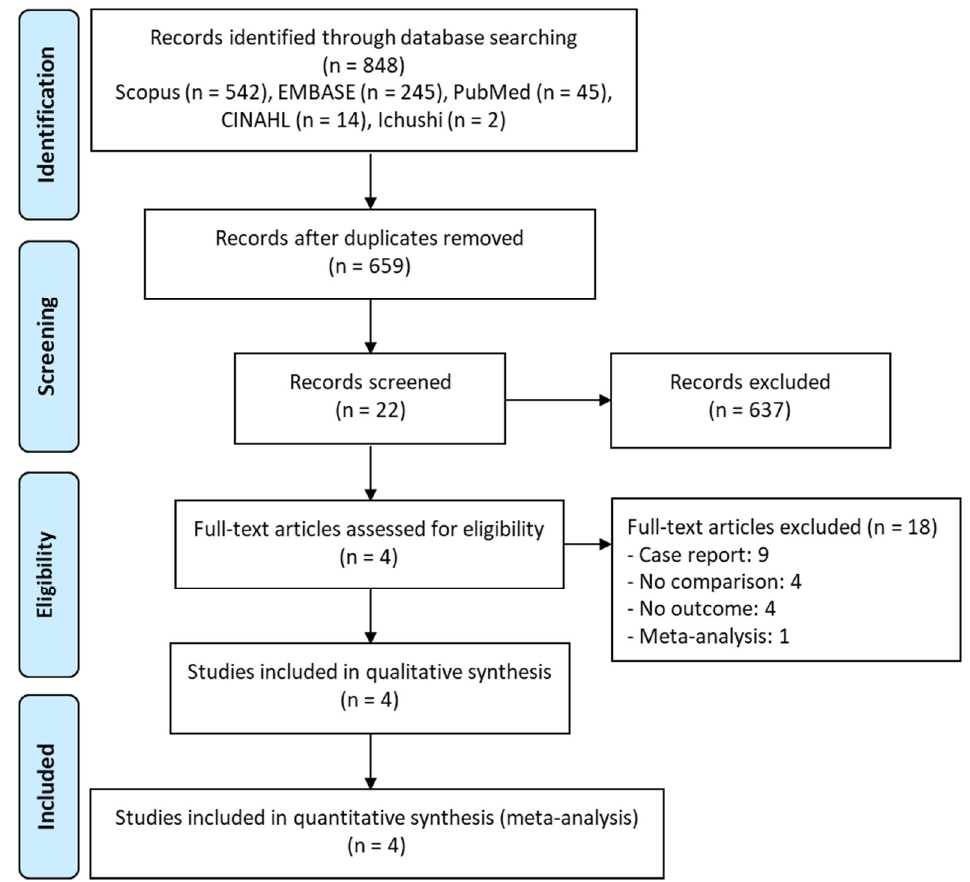
Figure 1. PRISMA flow diagram of the selection of eligible studies.